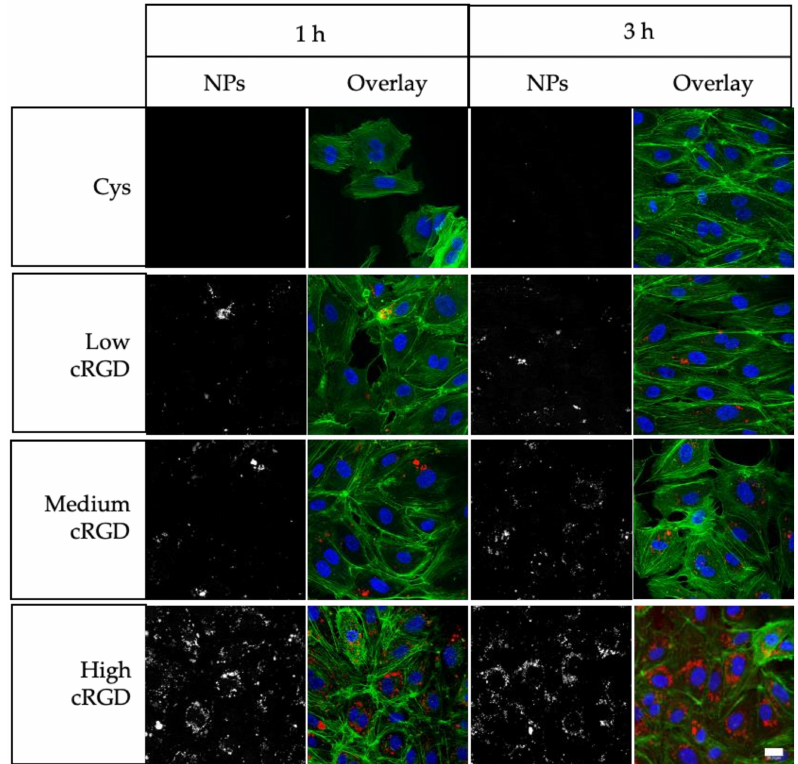
Figure 2. Uptake of Cys-NPs and cRGD-NPs of di ff erent ligand densities by HUVECs under static incubation conditions. Confocal cross-sections of HUVECs incubated with NPs for 1 and 3 h at 37 ◦ C. Nuclei are stained in blue, cytoskeleton (F-actin) is stained in green and NPs are depicted in red. Scale bar represents 20 µ